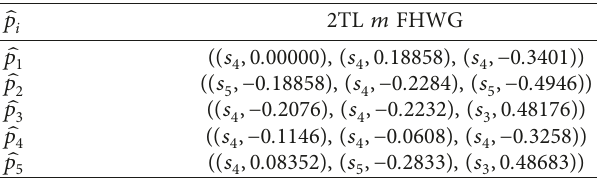
Table 5: Assembled assessment by using the operator.